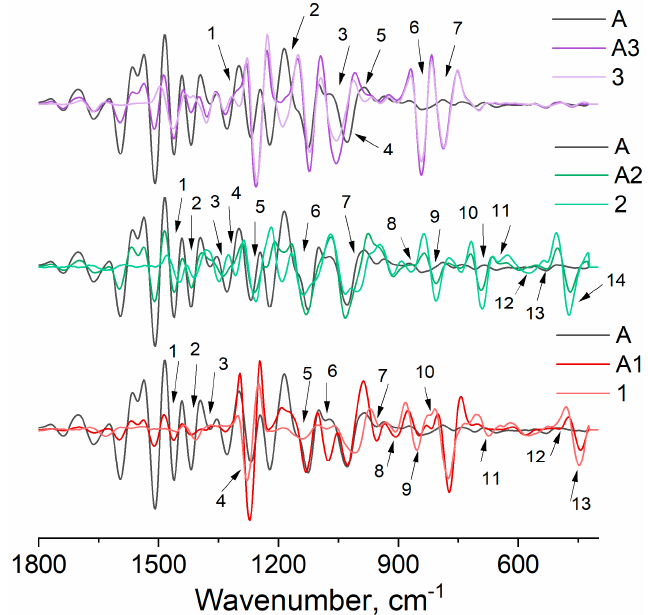
Figure 6. Second derivative spectra in the 1800–400 cm –1 region for the untreated archaeological elm wood (A), wood samples treated with particular organosilicons (A1, A2, A3) and pure silanes and siloxane (1, 2, 3).